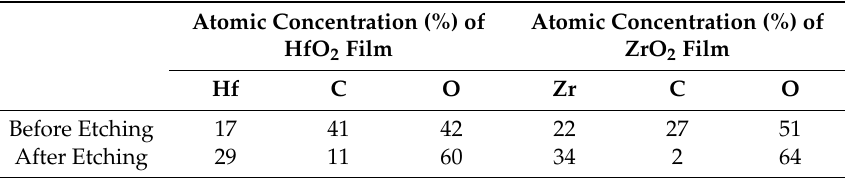
Table 1. Compositions of HfO 2 and ZrO 2 films measured by X-ray photoelectron spectroscopy (XPS) before and after